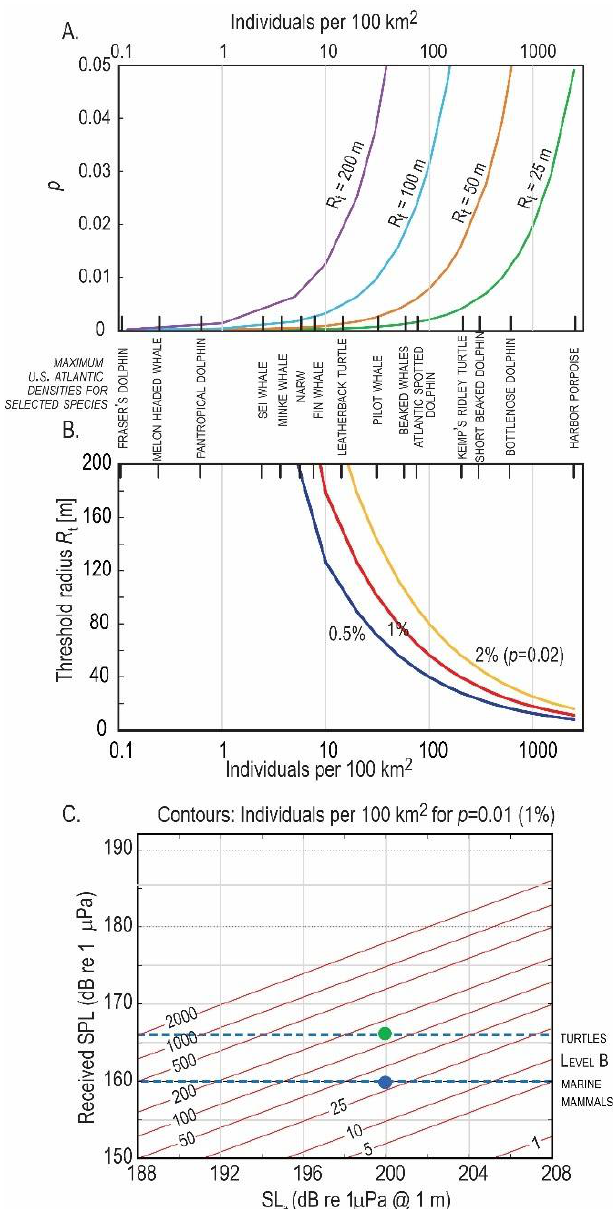
Figure 6. Factor 2 results from application of Equation (4), which assumes a random, uniform distribution of N individual animals at the surface of a single 100 km 2 cell, as illustrated in Figure S4. ( A ) For various values of the threshold radius R t as a function of animal density, the resulting p value is the probability of a single animal being with a distance R t of the source in the x-y plane. NMFS has previously applied 25 m (85 FR 14903 [64]) as a distance that would be equivalent to R t in our formulation, corresponding to p = 0.01 even for 500 animals per 100 km 2 . ( B ) R t as a function of animal density for different p values. [65]. The calculations in ( A , B ) are generic, but the maximum density of various cetacean [65] and turtle [66,67] species in U.S. Atlantic margin models is shown between the two graphs for comparison. ( C ) Received SPL vs. adjusted SL ( SL it ) calculated from R t for p = 0.01 (1%) and various marine animal densities indicated on the red contours. The calculation assumes spherical spreading, which applies at even very shallow water depths for many HRG frequencies. The 160 and 166 dB re 1 µ Pa thresholds for Level B incidental harassment are shown as blue dashed lines for marine mammals and turtles, respectively. The blue and green circles denote mammal density of 32 animals per 100 km 2 and turtle density of 128 per 100 km 2 , respectively, for SL it = 200 dB re 1 µ Pa @ 1 m.